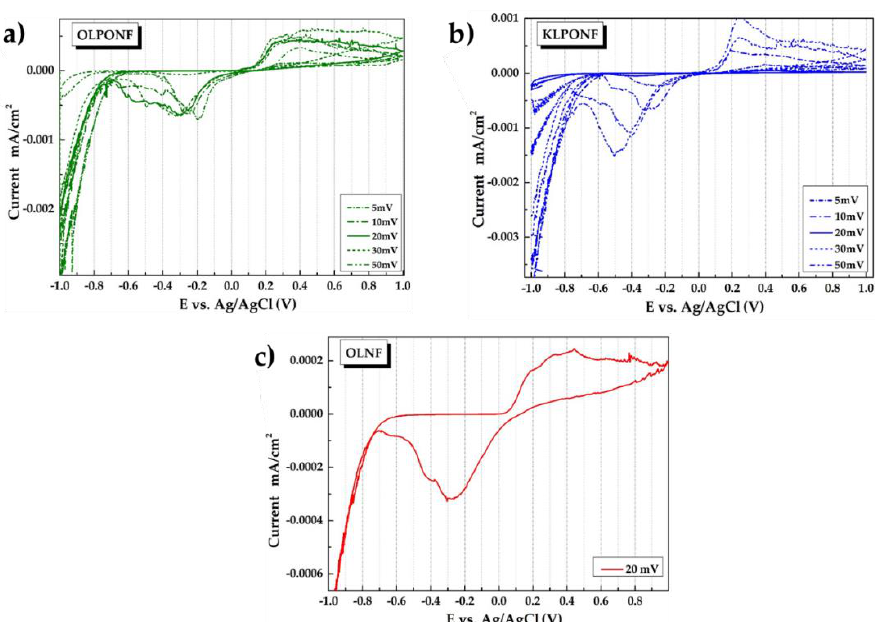
Figure 9. Shows the four cyclic voltammetry (CV) profiles of the OLPO, OLNF, OLPONF, and KLPONF electrodes performed in the window of −1 V to 1 V potential range at the scan rate of 20 mVs −1 .